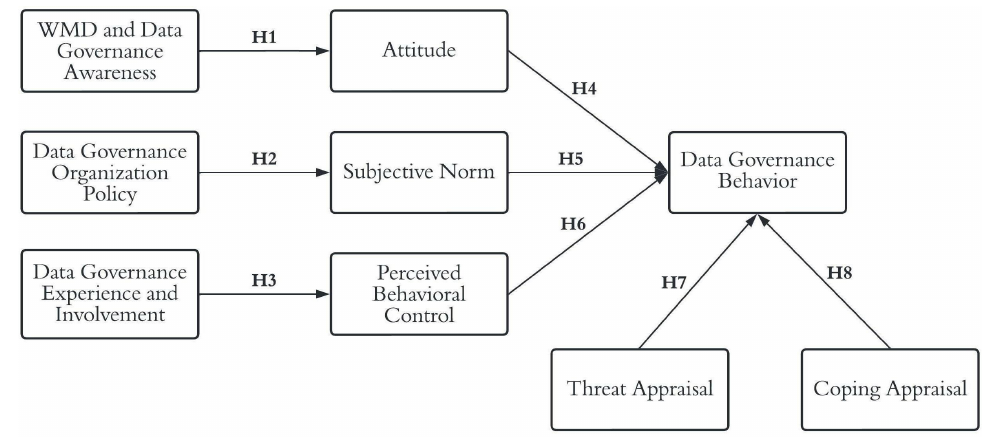
Figure 1. Research